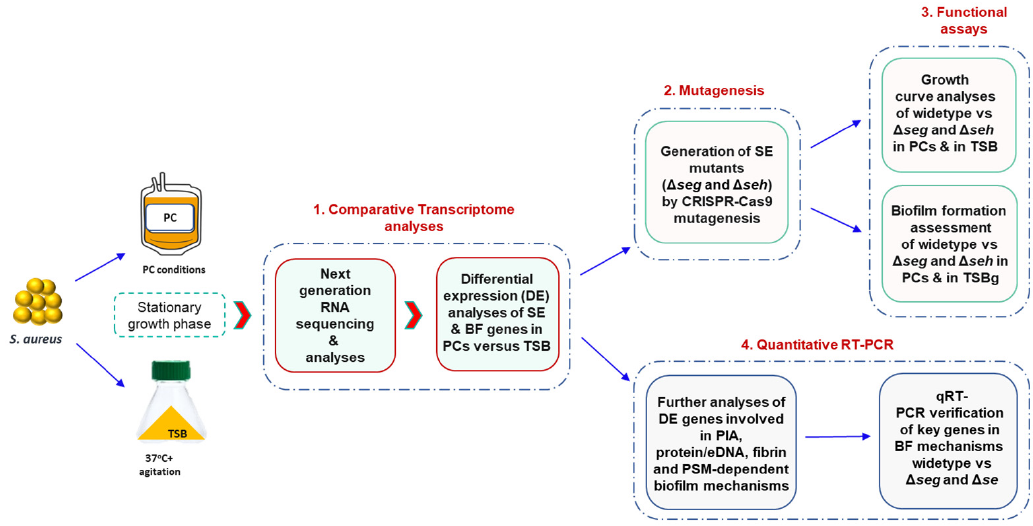
Figure 1. Methodologies used in this study. (1) RNA extracted from S. aureus cultures grown to stationary phase in PCs or TSB was subjected to next generation RNA sequencing. (2) Based on differential gene expression, genes encoding for enterotoxins SEG and SEH were deleted using CRISPR-Cas9 mutagenesis. (3) Functional assays of the wild-type and mutant strains, including growth curves and biofilm formation, were performed. (4) Further bioinformatic analysis and qRT-PCR analyses were conducted to propose scenarios for modulation of S. aureus growth and biofilm development in PCs. PC; platelet concentrate, TSB; trypticase soy broth, TSBg; trypticase soy broth supplemented with 0.5% glucose, SE; Staphylococcal enterotoxin, BF; biofilm formation, PIA; polysaccharide intracellular adhesin, and PSM; phenol soluble modulin.